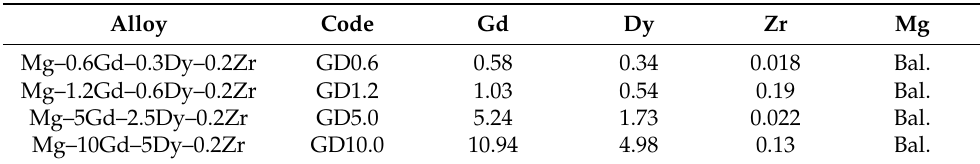
Table 1. Chemical composition of the Mg–Gd–Dy–Zr alloys (wt%).